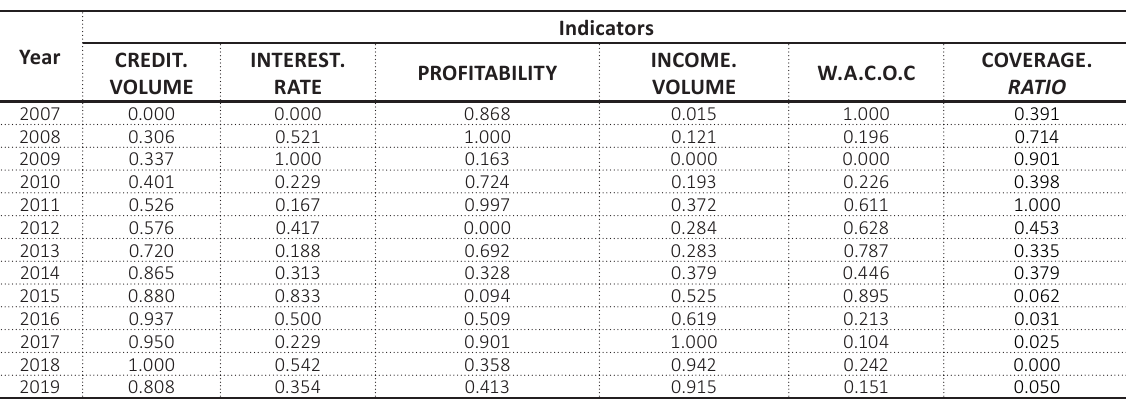
Table 3. Normalized initial data for modeling